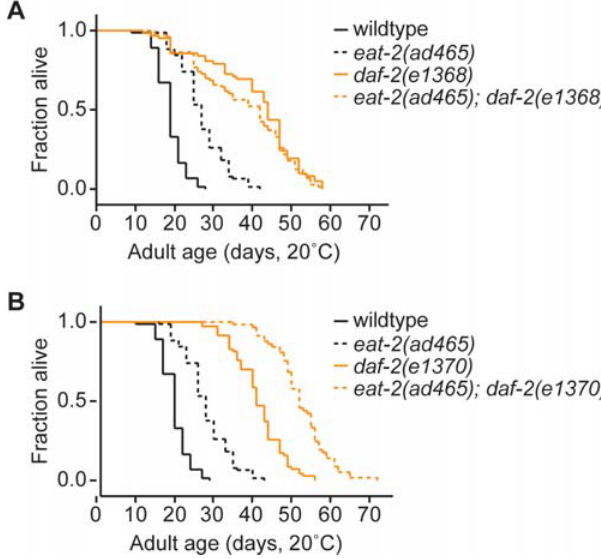
Figure 5. Levels of daf-2 activity modify lifespan of eat-2(ad465) animals. DR, from the eat-2(ad465) mutation, had an additive effect on lifespan of daf-2(e1370) adults (B), but not on lifespan of daf-2(e1368) adults (A). Lifespan data and statistics are presented in Table